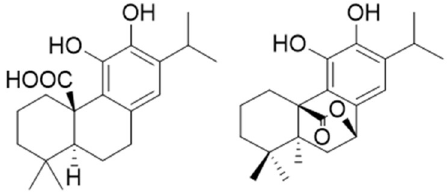
Figure 1. Structures of Carnosic acid and Carnosol.